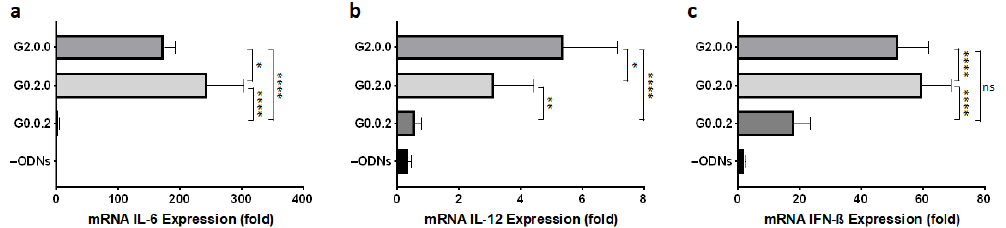
Figure 3. Induction of ( a ) IL-6, ( b ) IL-12, and ( c ) IFN- β mRNA transcription in RAW264 cells (1 × 10 5 cells/well) stimulated with 2 µ M duplex/G-quadruplex-based CpG ODNs. G2.0.0, G0.2.0, and G0.0.2 contain two CpG motifs in first, second, and third loop, respectively. –ODNs indicate RAW264 cells with only D-PBS buffer added. Data are presented as the mean ± SD ( n = 5). **** p < 0.0001, ** p < 0.01, * p < 0.05, ns: not significantly different (one-way analysis of variance, Tukey’s multiple comparisons test for comparison with other